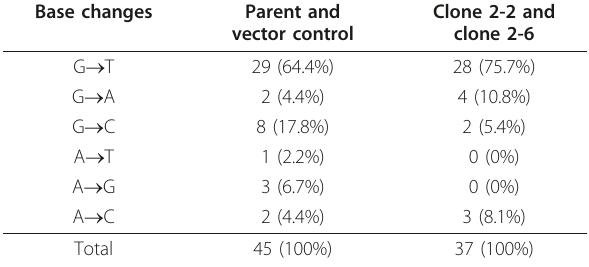
Table 1 Types of base substitutions induced by BPDE in the HPRT gene of cells with normal or reduced levels of hRev7 Base changes Parent and vector